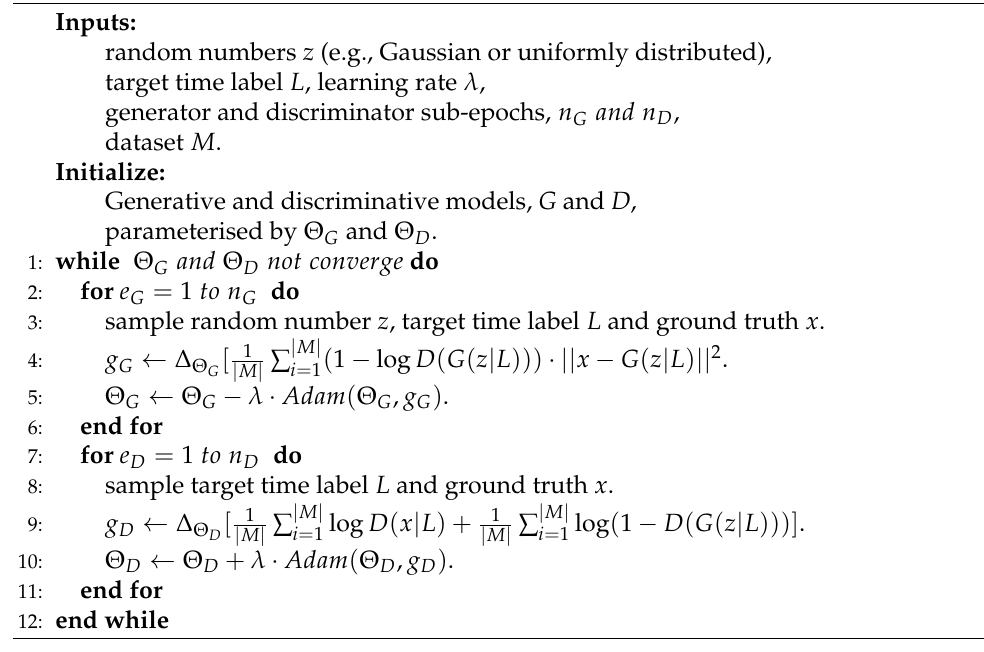
Algorithm 1 The CSR-GAN training